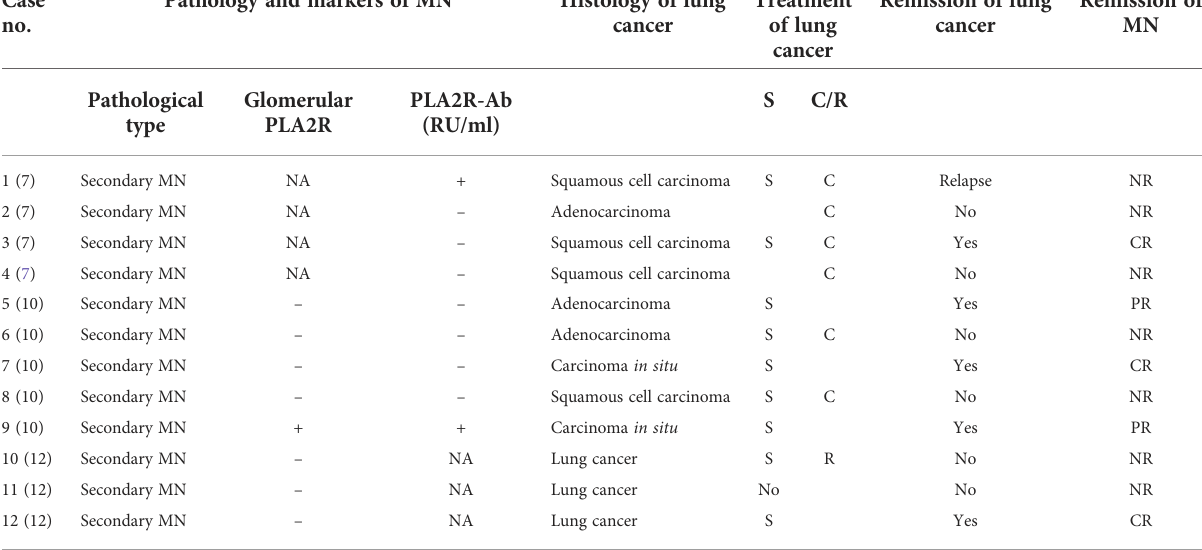
TABLE 2 Review of the literature on lung cancer patients with nephropathy as the fi rst manifestation. Case